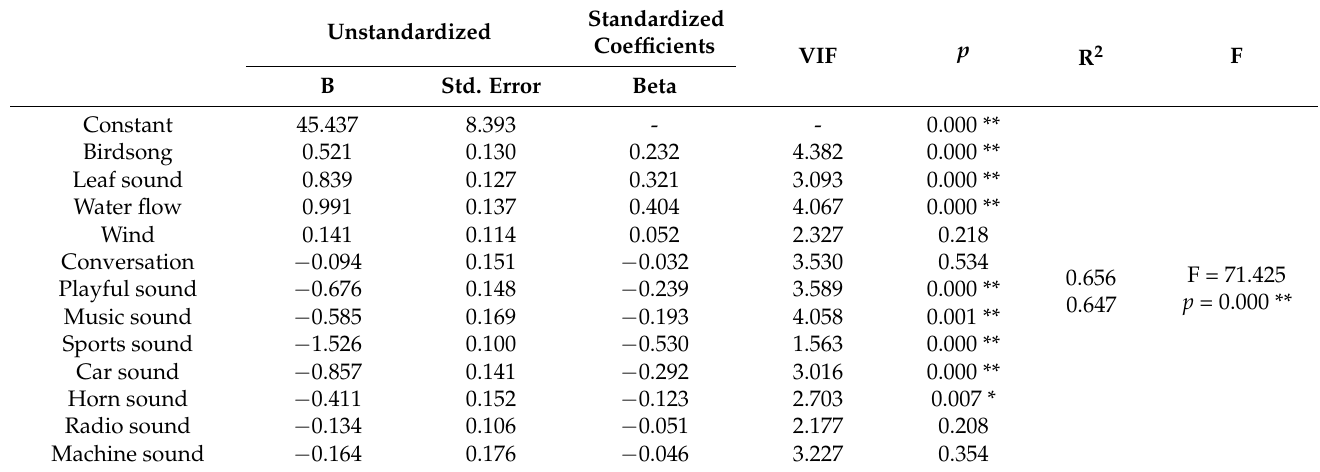
Table 11. Linear regression model between acoustic environment type and RMSSD.